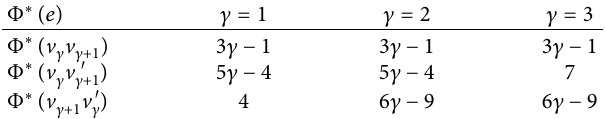
Table 33: Edge labeling of Φ ∗ ( e ) .